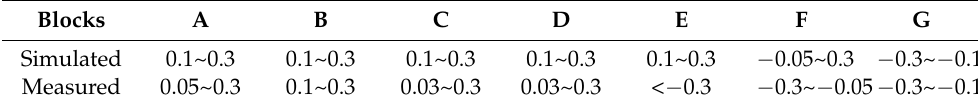
Table 1. The quantitative comparison of blocks A–G: simulated thickness of deposition and scour vs. annual average change of measured terrain from 2005 to 2011. (unit: m; positive: deposition; negative: scour).